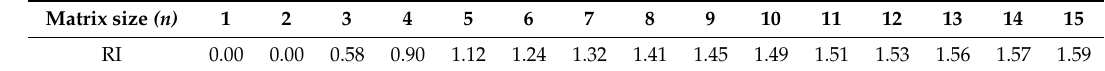
Table 2. RI coefficient